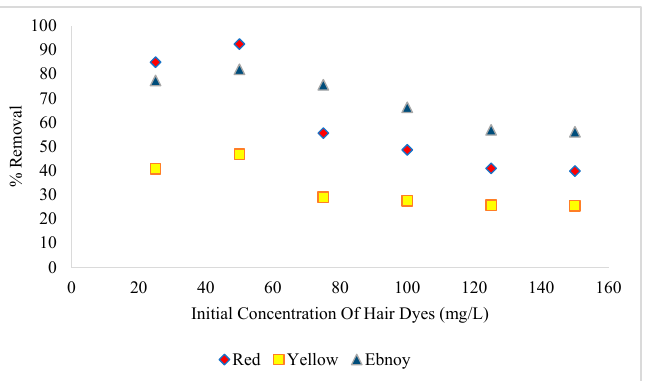
Figure 6. Effect of adsorbate initial concentration (25–150 mg · L − 1 ) on the adsorption of red, yellow, and E, 150 min for Y, T = 25 ± 1 °C, speed = 150 rpm]. and ebony hair dyes; [dosage = 0.07 g R, 0.06 g Y, & 0.05 E, pH = 7.0, contact time = 120 min for R and E, 150 min for Y, T = 25 ± 1 ◦ C, speed = 150